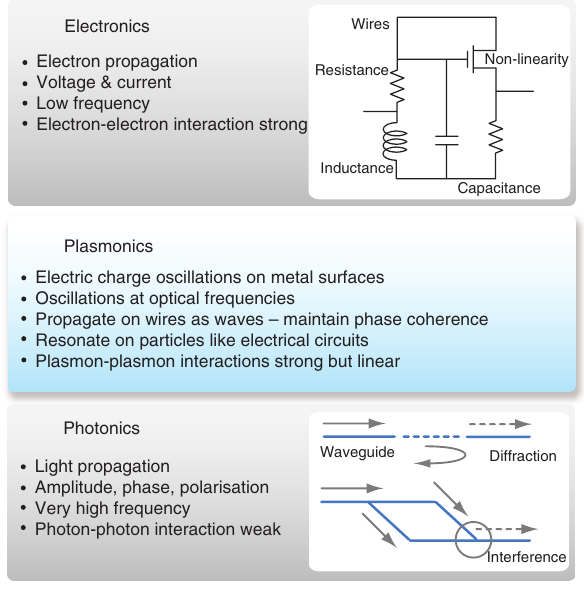
Figure 1: A comparison between electronic and photonic circuits. The field of plasmonics lies in